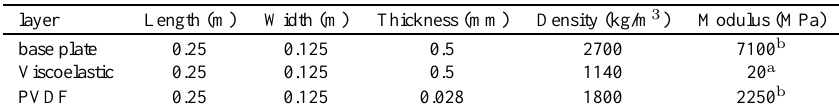
Table 1 Physical and geometrical parameters of plate/ CLD system